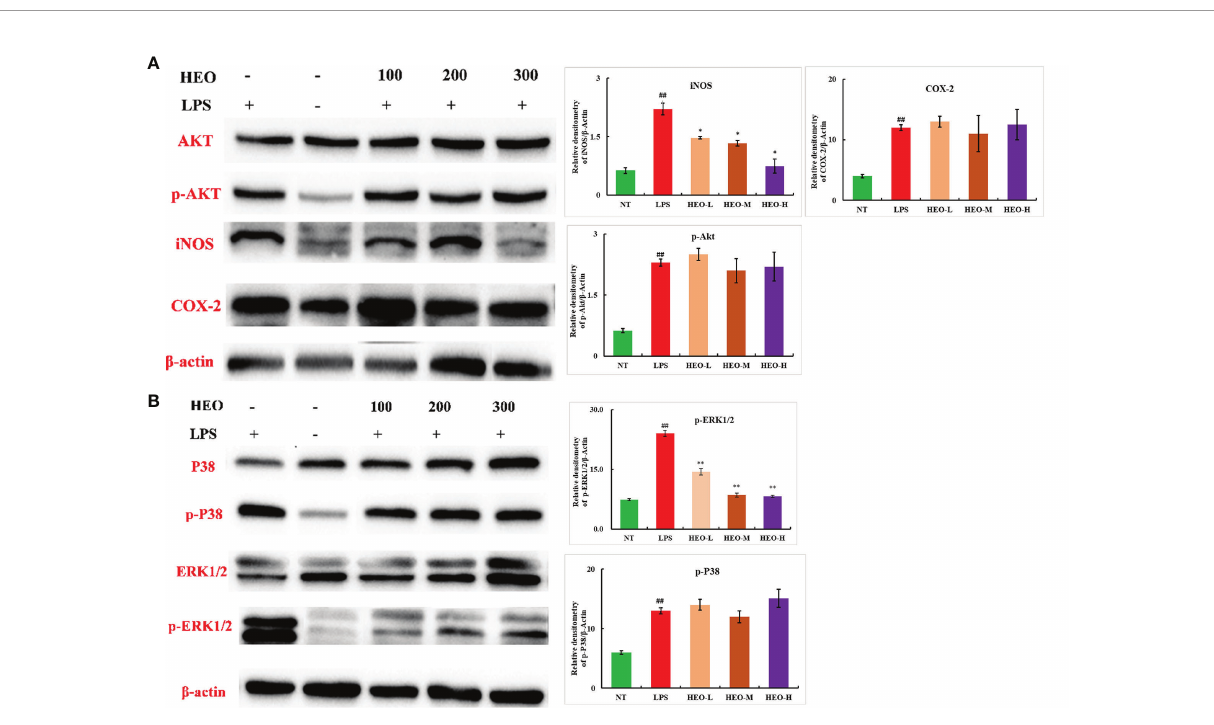
FIGURE 11 | Effects of HEO on proteins associated with in fl ammatory pathways. (A) HEO inhibits iNOS expression. (B) HEO hinders ERK1/2 phosphorylation. Mean ± SD, n = 6. ## P < 0.01 compared to blank group; * P < 0.05, ** P < 0.01 compared to model